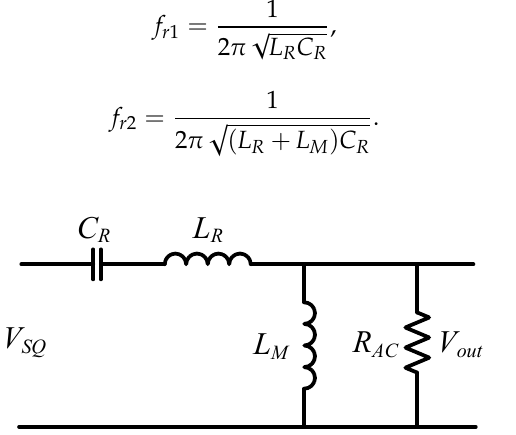
Figure 5. Simplified converter circuit of the LLC half ‐ bridge converter.